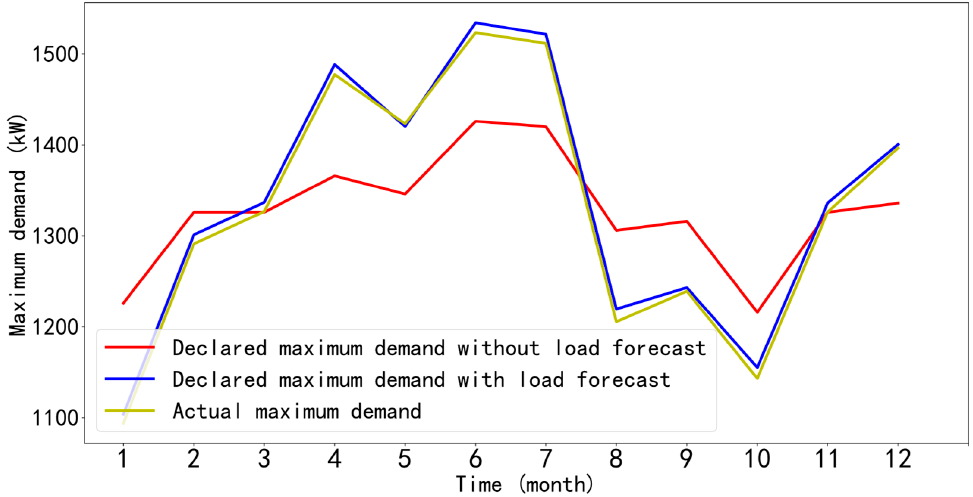
Figure 10. Change curve of declared demand with and without load forecast.